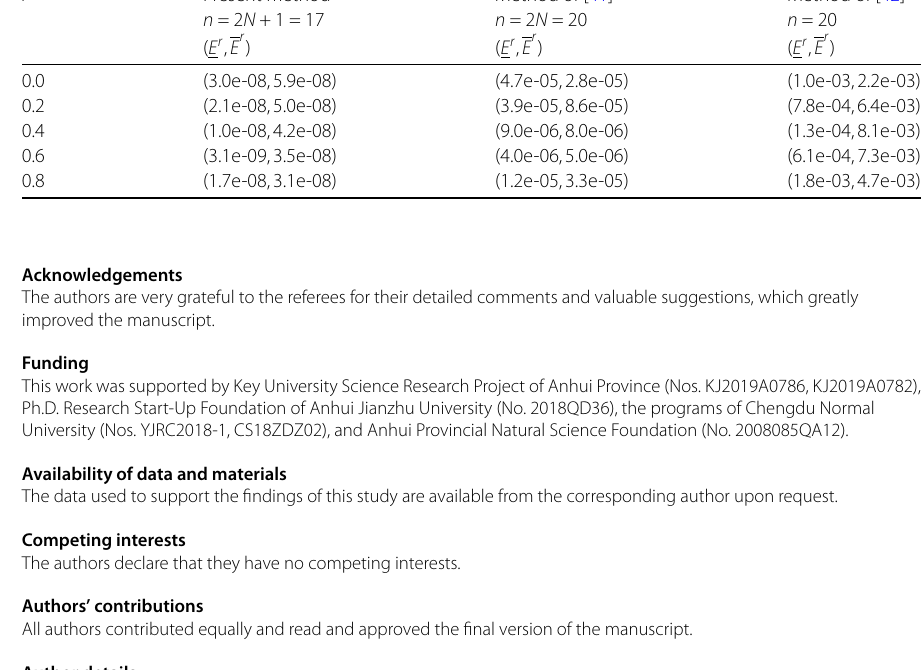
Table 6 Comparison of methods with ( x , y ) = (0.5.0.5) of Example 5.3 r Present